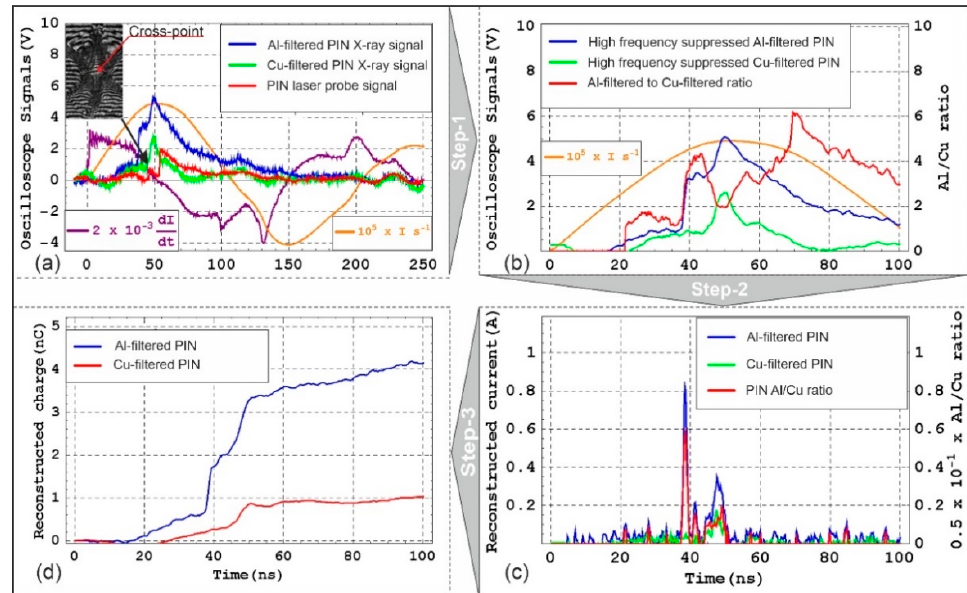
Figure 4. ( a ) Electrical signals of a typical shot. ( b ) Signals resulting from the first step of the reconstruction procedure. ( c ) Reconstructed current wave forms for the two filtered PIN diode signals, and for their ratio. ( d ) Time integral of the reconstructed current. The dI/dt and I waveforms are plotted in purple- and brown-colored lines, respectively.